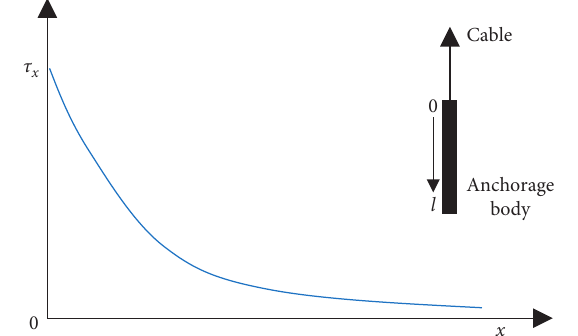
Figure 3: Exponential (Phillips) shear stress distribution [10, 11].